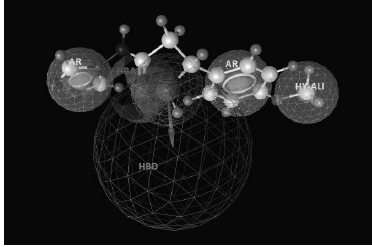
Figure 2. Pharmacophore mapping of pyrazoline